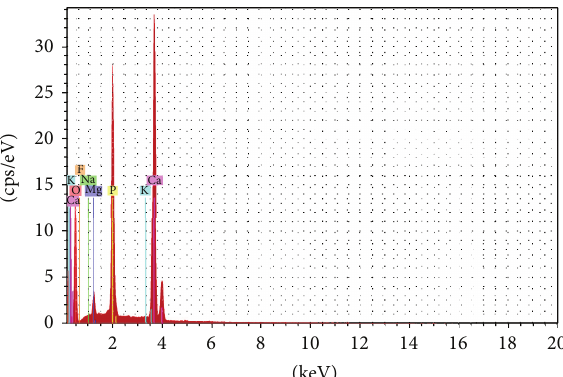
Figure 10: The EDXA spectrum of hydroxyapatite (HA) synthesis from crab